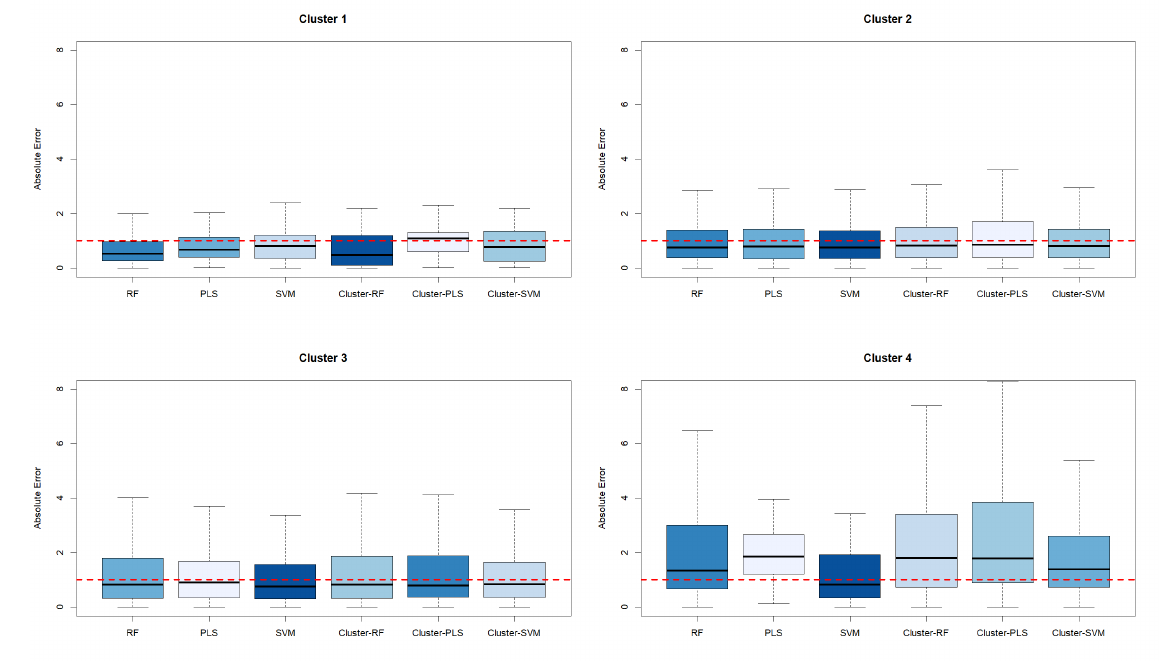
Figure 5 - Performances of the different methods (RF: random forest, PLS: partial least squares, SVM: support vector machines) in terms of the log of the absolute error of the CF HT with respect to the different clusters for 200 repetitions. In each cluster, the models are coloured from dark blue (best) to clear blue (worst) according to their median of the absolute error. The red dotted line represents an absolute error of 1 log that is considered as acceptable (Rosebaum et al. 2008 ; Douziech et al.,